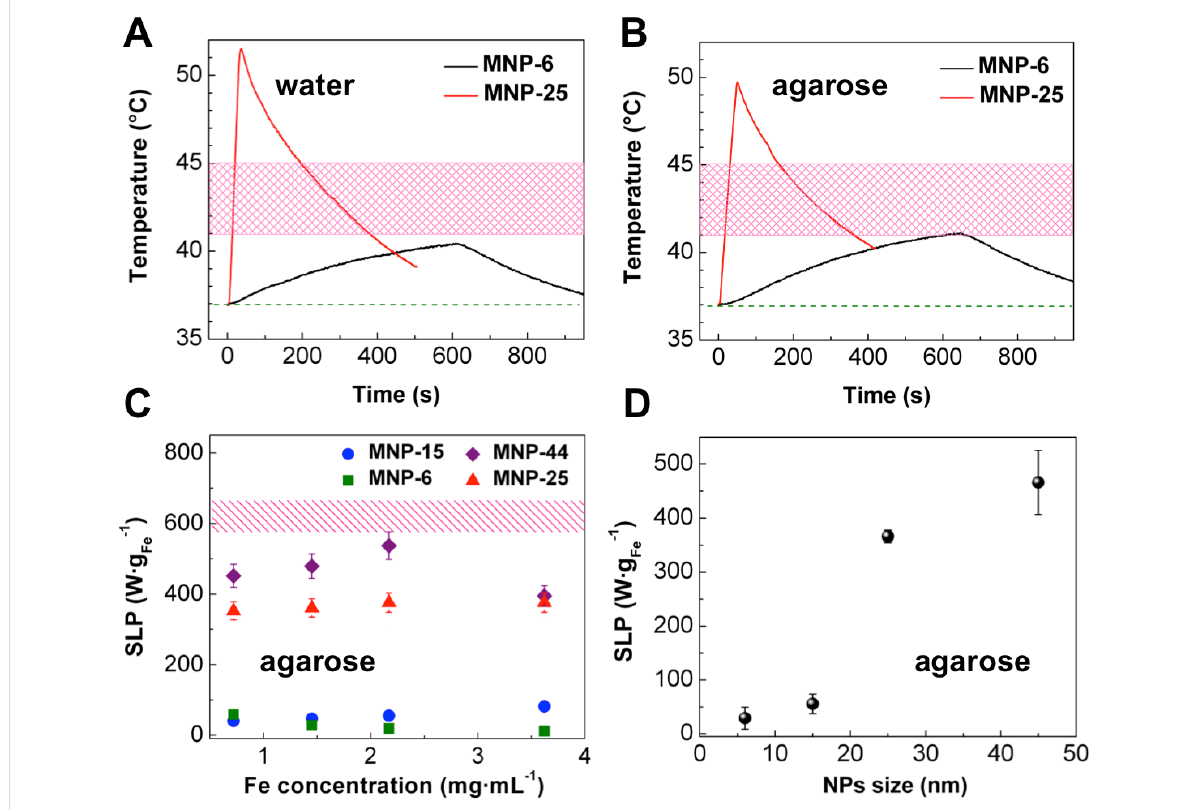
Figure 6: MPH experiments (765 kHz, 30 mT). The heating curves of MNP-6 and MNP-25 (3.6 mg·mL − 1 Fe) in water (A) and agarose (B), the shaded bands show the 41–45 °C region; SLP values for MNP-6, MNP-15, MNP-25 and MNP-44 samples for various concentrations in agarose compared to the reference values for MNP-25 (3.6 mg·mL − 1 Fe) in water shown by the shaded band (C); the comparison of concentration-averaged SLP values for the NPs of various size (D). The error bars in (C) and (D) correspond to the standard deviation.